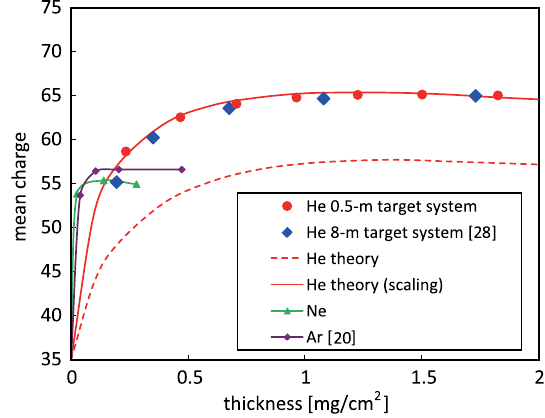
FIG. 7. Measured and calculated charge-state evolution for He, Ne, and Ar [20]. The maximum mean charge state for He of around 65+ was obtained in both the 0.5-m and 8-m target systems. The calculation was performed using the charge- [30] and (cid:2) [31] for 238 U , while changing cross sections (cid:2) BEM Sch accounting for energy attenuation in the gas stripper. In addition, the calculation with scaled cross sections is